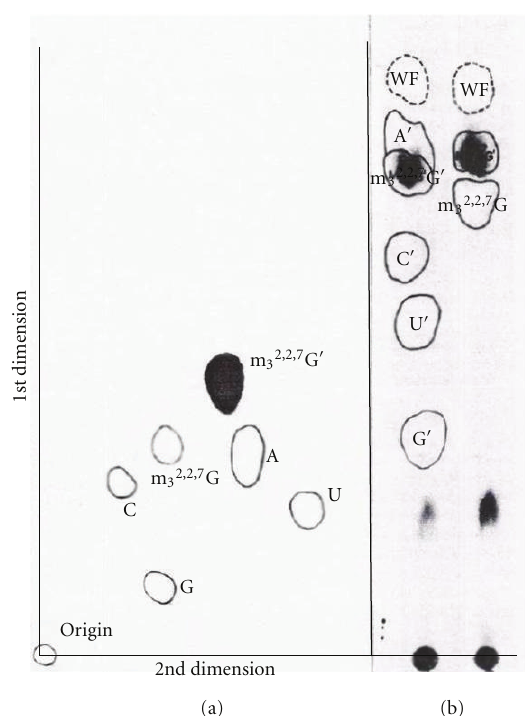
Figure 19: Identification of m 32,2,7 G (cid:2) [16]. (a) Fluorogram of two- dimensional thin layer chromatography of [ 3 H]-labeled nucleoside trialcohol derivative (N (cid:2) ) released from U1 RNA 5 (cid:2) fragment. It was identified as m 32,2,7 G (cid:2) with standard. (b) Fluorogram of chromatographic separation of [ 3 H]-labeled nucleoside trialcohol derivative on Whatman 3MM paper. The [ 3 H]-labeled compound was identified as m 32,2,7 G (cid:2) with standard.